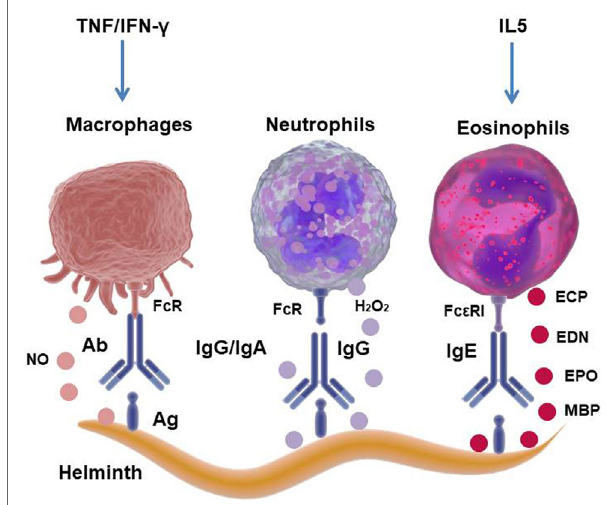
FiGURe 2 | Mechanism of cellular cytotoxicity mediated by antibodies against helminth parasites. The interaction of the antibodies that cover the parasite with the Fc receptors present in eosinophils (Eos), neutrophils, or macrophages (Mo) induces degranulation and the release of lysosomal/ granular content, hydrogen peroxide (H 2 O 2 ) or nitric oxide (NO), causing lysis of the helminth. Eos granules contain parasite toxic proteins, such as major basic protein (MBP), eosinophil peroxidase (EPO), eosinophil cationic protein (ECP), and eosinophil-derived neurotoxin (EDN).